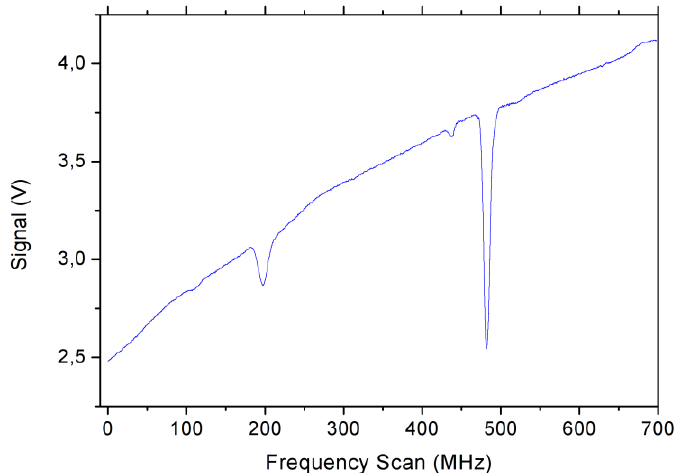
Figure 2. Absorption profile of methanol vapor at a pressure P = 0.4 mbar, obtained